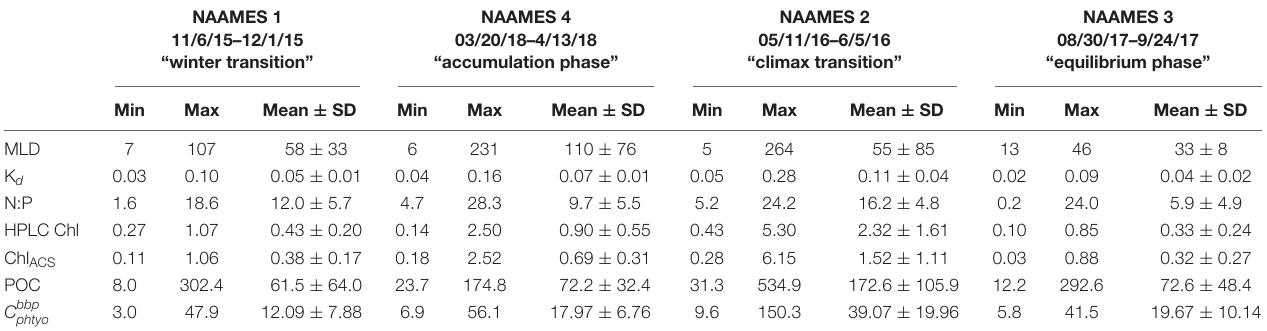
TABLE 2 | Mean and standard deviation, maximum and minimum values of physical, biological and chemical parameters measured during the four NAAMES field campaigns. NAAMES 1